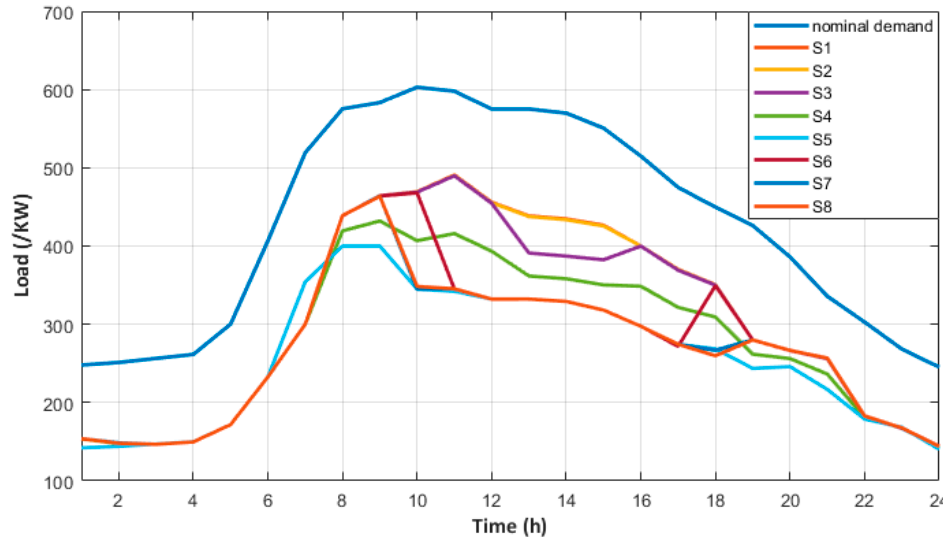
Figure 10. Nominal demand and demand per scenario for 14 August 2019. (source: Authors).